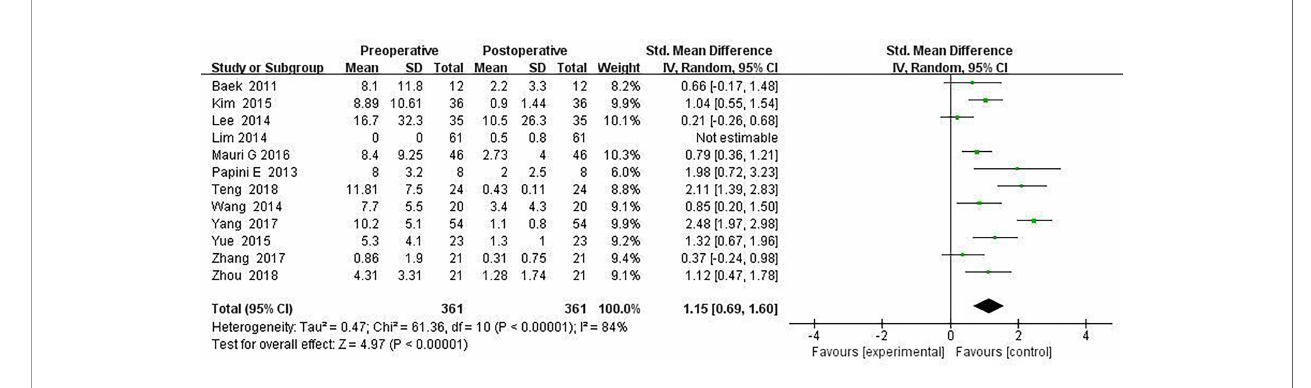
FIGURE 4 | Forest plots of thyroglobulin changes before and after